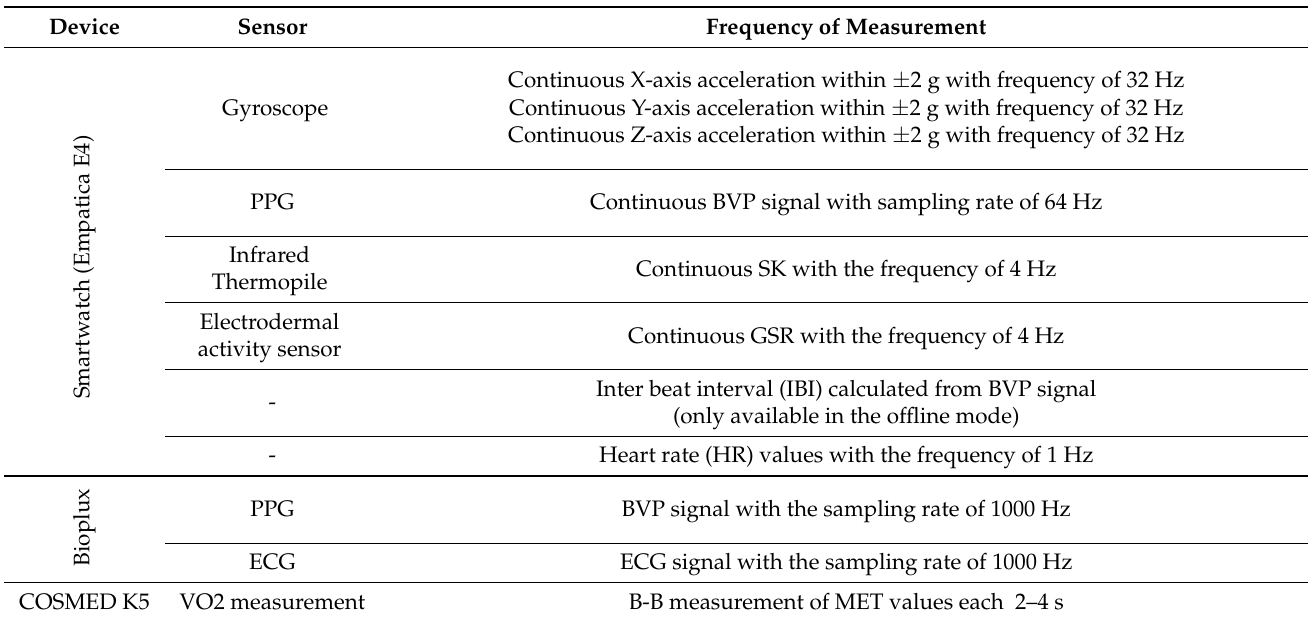
Table 1. Characteristics of the measurement devices used in this